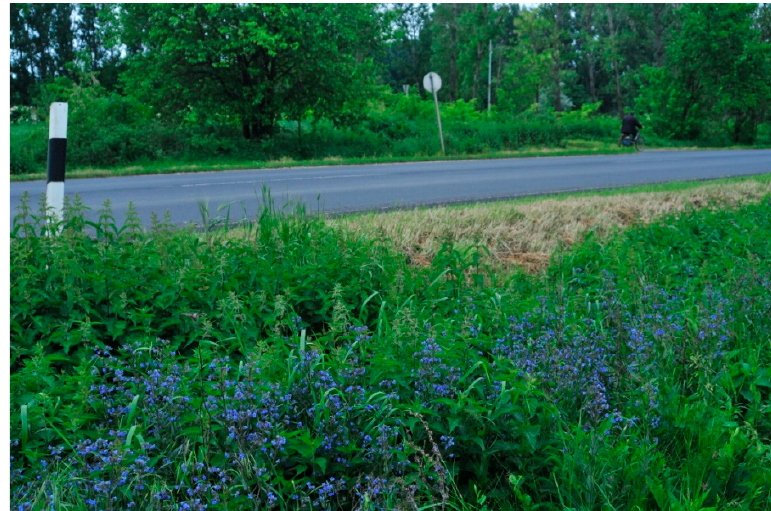
Figure 7. Border verge with a protected Anchusa barrelieri population, Kondoros (Photo: Zsuzsanna Sutyinszki).